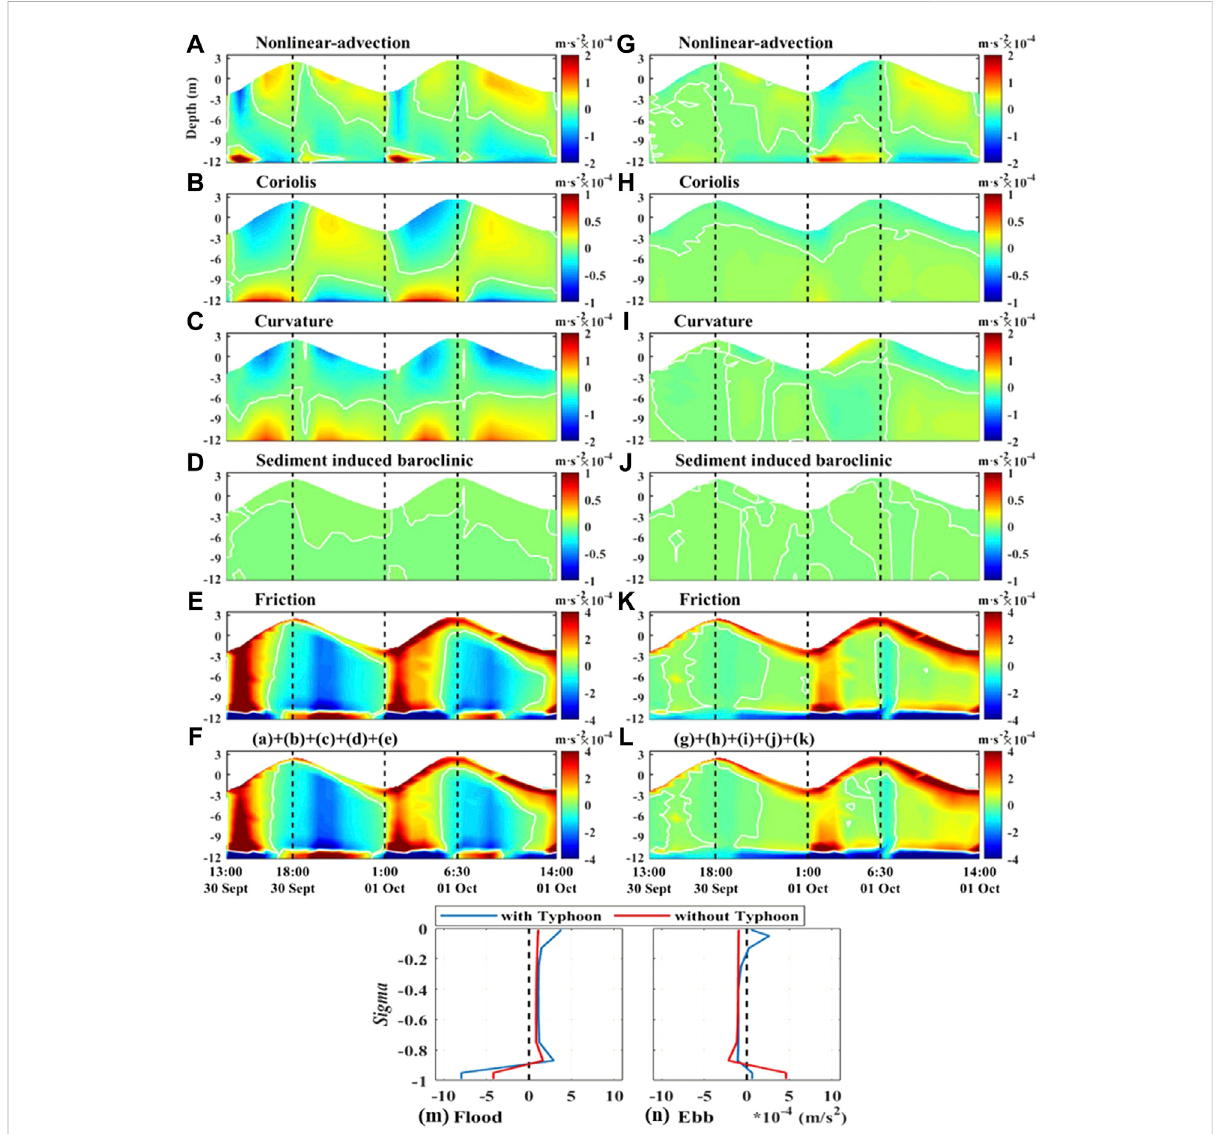
FIGURE 10 Timesseries inthemaintidalchannelatstationP(duringTyphoon Mitag) during (A – F) spring tides and (G – L) neap tides:vertical deviation from depth-averaged terms in lateral momentum (Eq. 16). Vertical pro fi le of the principal momentum terms in Eq. 16 at station P during (M) fl ood and (N) ebb tides during the typhoon. Positive values indicate southward